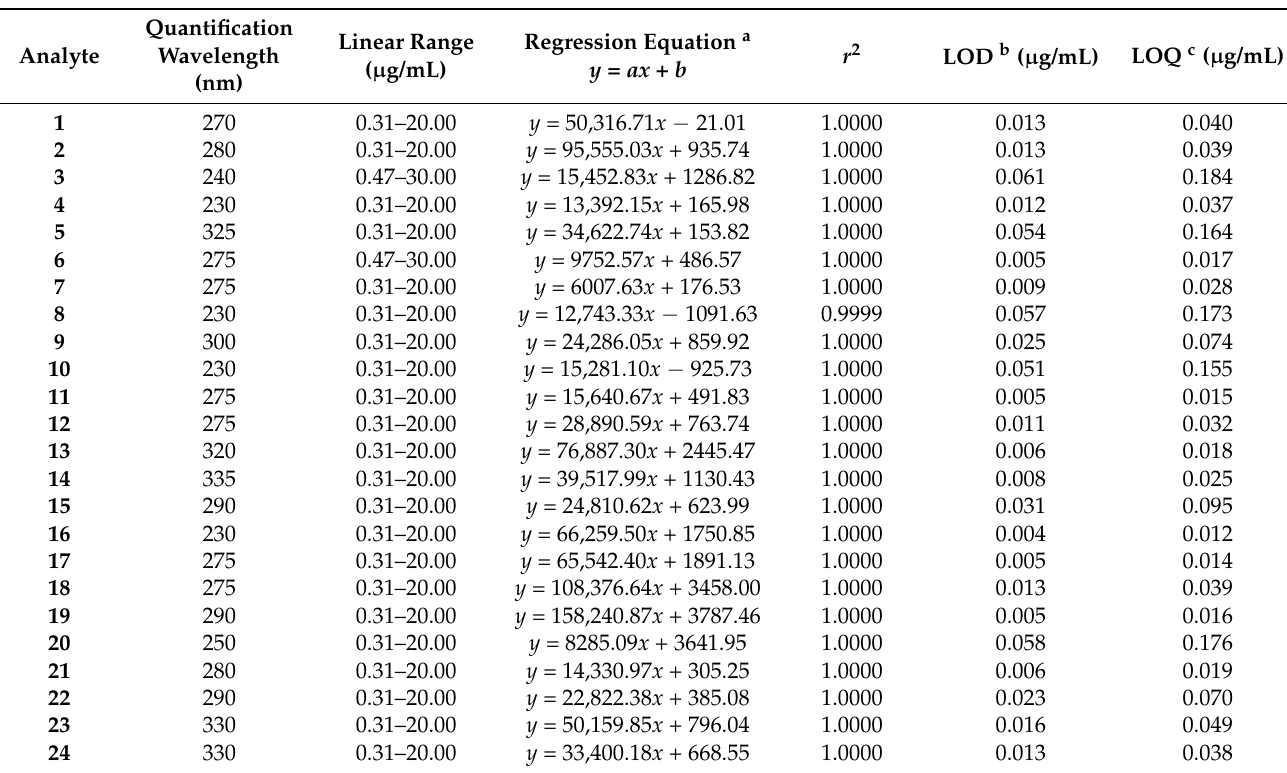
Table 1. Linear range, regression equation, coefficient of determination ( r 2 ), limit of detection (LOD), and limit of quantifica- tion (LOQ) of 24 marker analytes for quantification by HPLC ( n = 3).